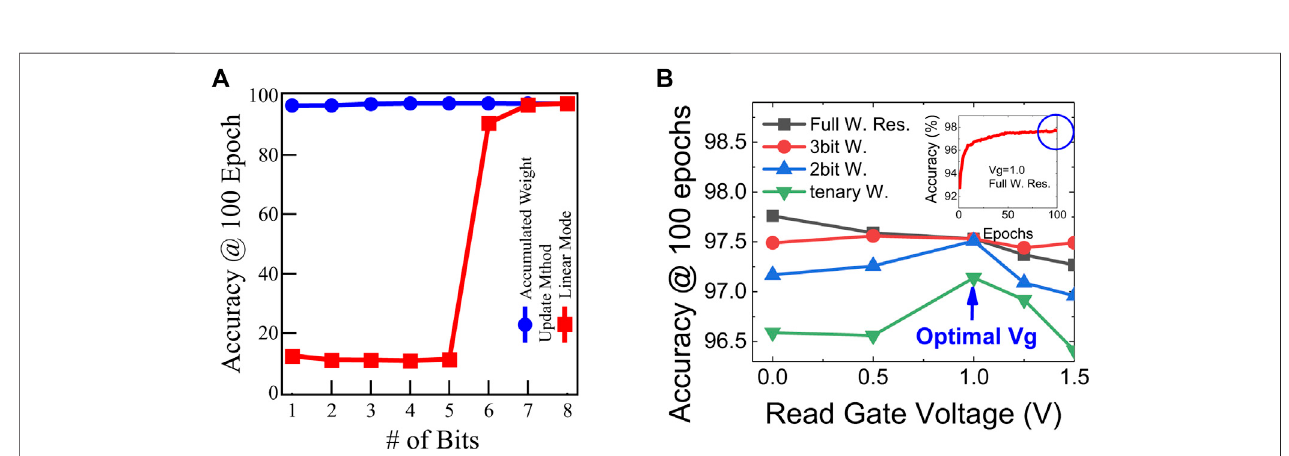
FIGURE 9 | (A) Accumulation mode operation requires less number of bits to achieve high accuracy compared to the trivial weight update mechanism. However, this accumulated weight update method requires an extra high precision volatile memory block. (B) V gread optimization for recognition accuracy.